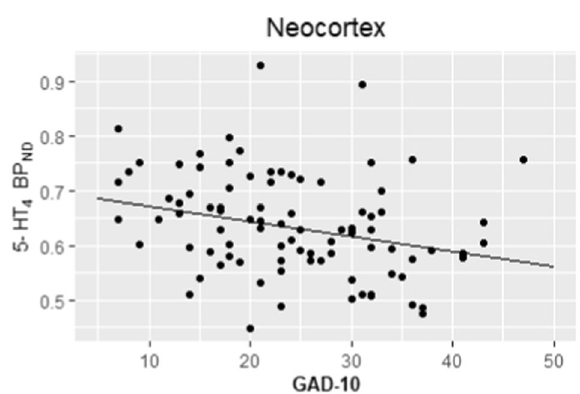
Fig. 2 Partial residual plot showing the association between baseline 5-HT 4 R BP ND in neocortex and GAD-10 (adjusted for covariates). Adjustment is performed using a linear regression on the log-transformed binding, subtracting the covariate effects compared to a female subject, age 25, non-LALA, injected mass/ kg of 0.0085 and a HAMD item 1 + 2 score of 5 as